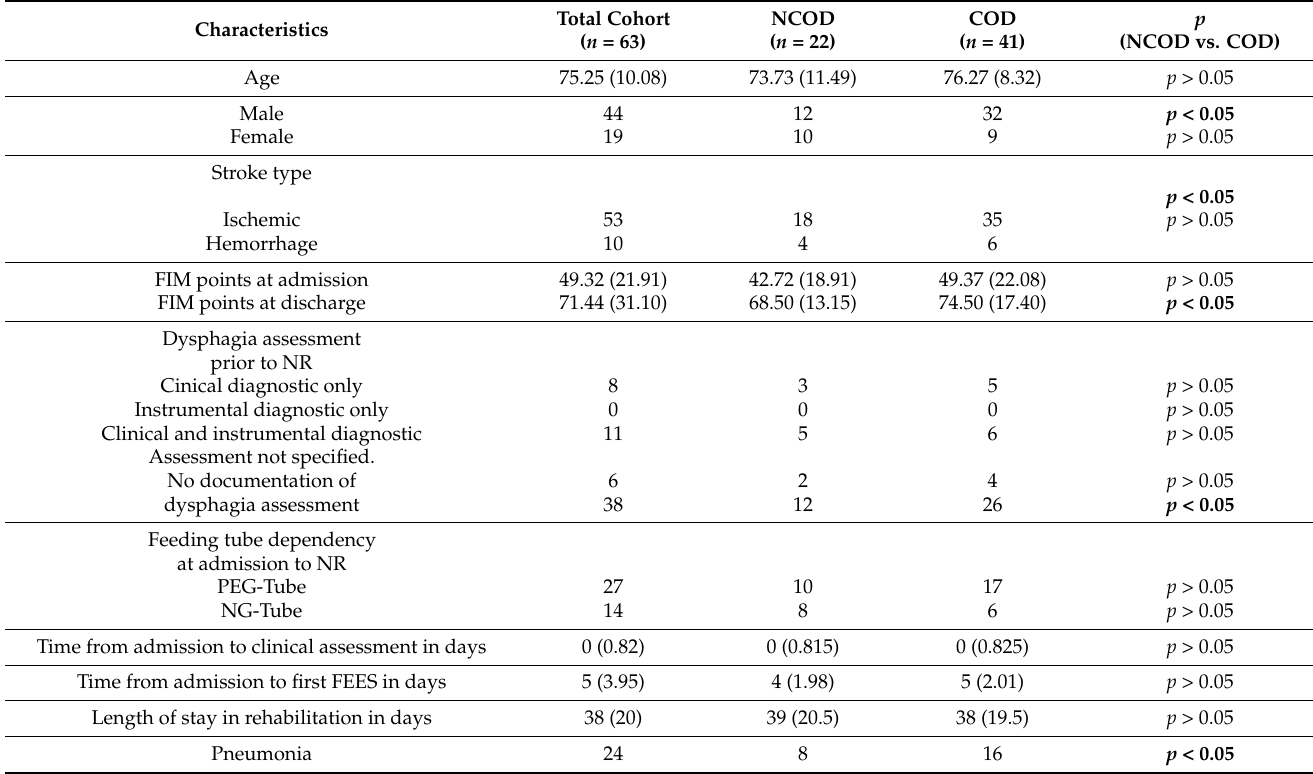
Table 1. Baseline characteristics of the study group ( n = 63) and differences in patients with and without a change in diet